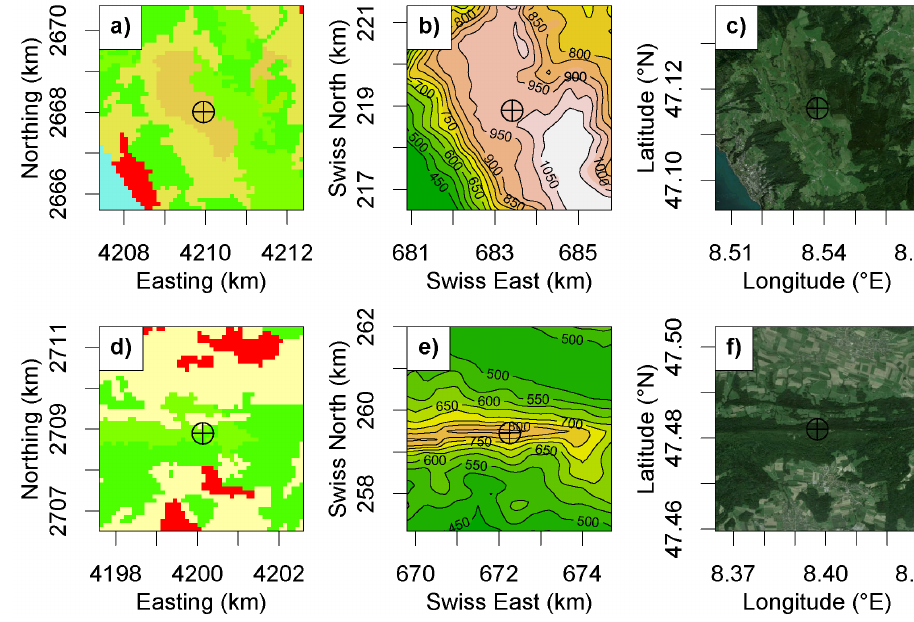
Figure 3. Similar to Fig. 2 with Früebüel (a – c) in the first row and Lägern-Hochwacht (d – f) in the second